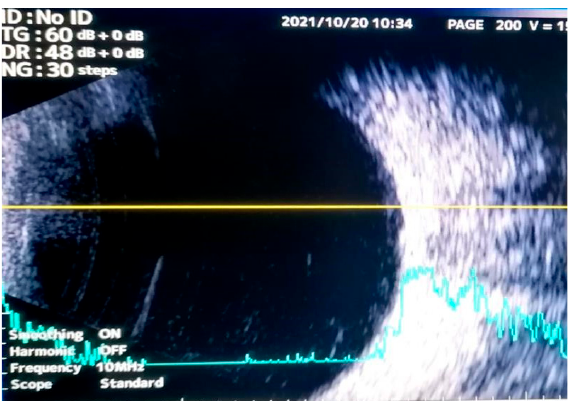
Figure 2. Standardized B-scan ultrasonography of the left eye did not reveal the presence of any intraocular mass. Computed tomography (CT) of the brain and orbit showed a front-ethmoid tissue mass with bone destruction and regional invasion (Figure 3).